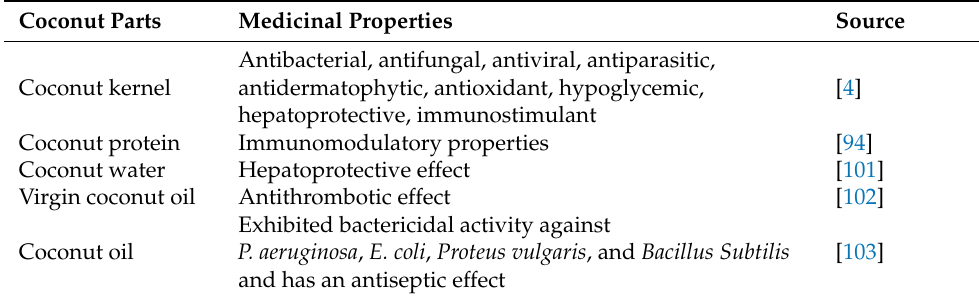
Table 3. Medicinal properties of various coconut parts, data from previous studies [4,94,101–103]. Coconut Parts Medicinal Properties Source Antibacterial, antifungal, antiviral, antiparasitic, Coconut kernel antidermatophytic, antioxidant, hypoglycemic, Coconut